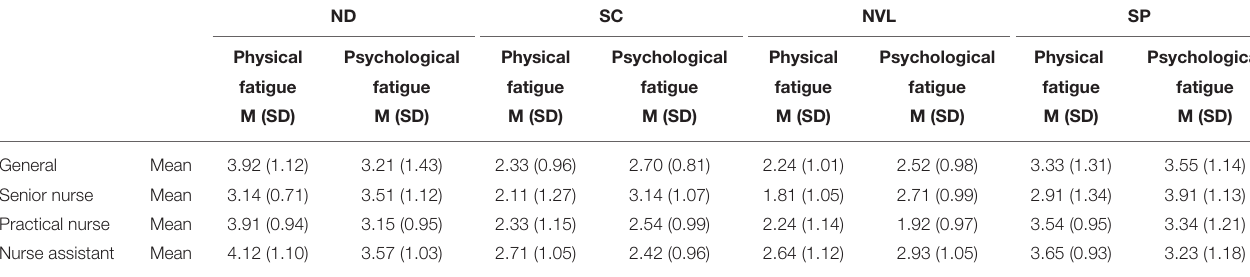
TABLE 3 | The descriptions of the environmental factors on the